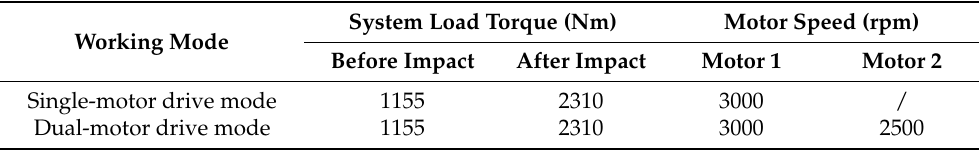
Table 6. Parameter of the system under impact conditions.